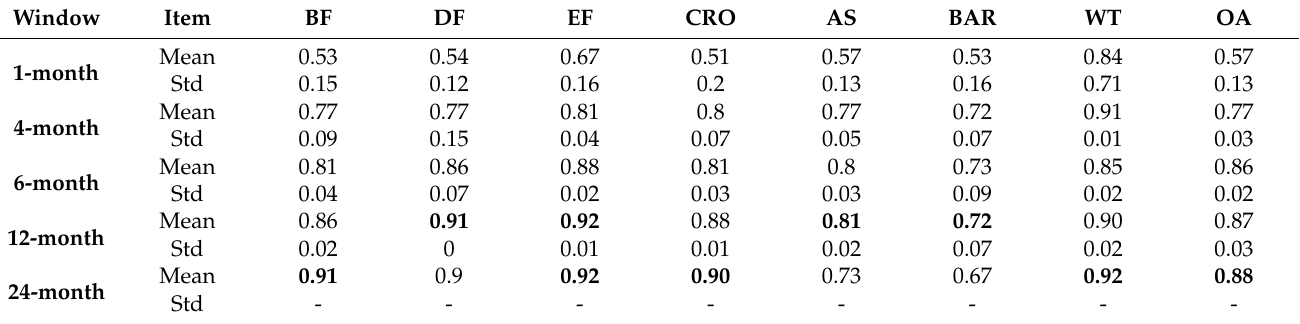
Table 4. Statistics of classification performance using different lengths of time windows. Mean value represents average resulting F1-score/OA of using all possible input feature schemes. Std is the standard error of using all possible schemes. The best performance of each category is labeled in